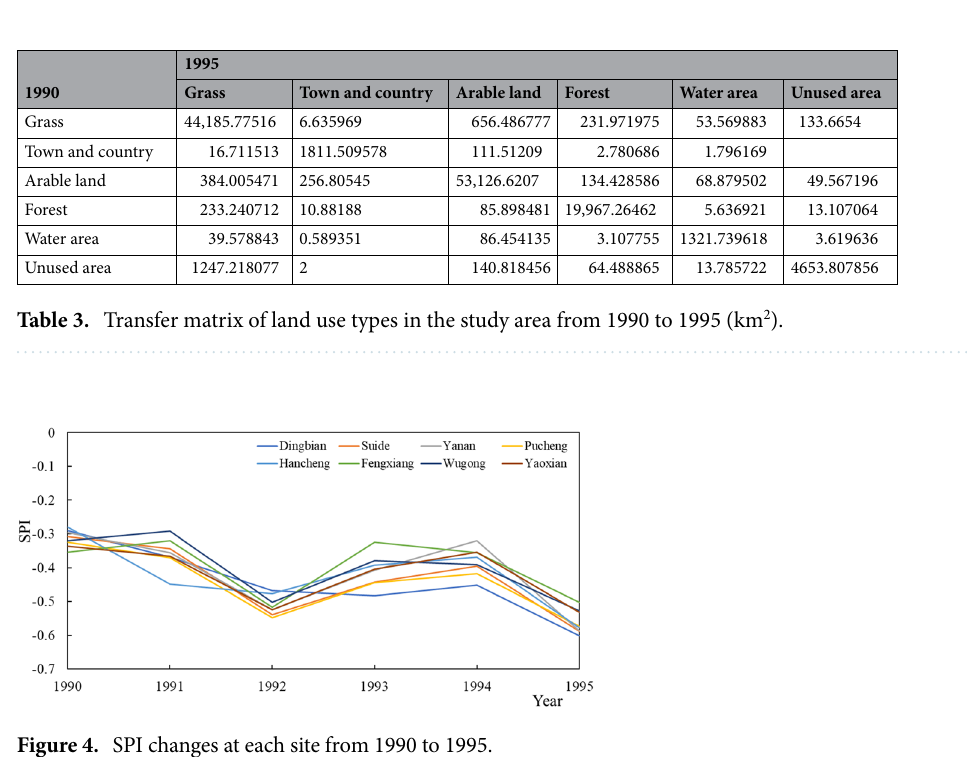
Figure 3. SPI changes at each site from 1980 to 1990.